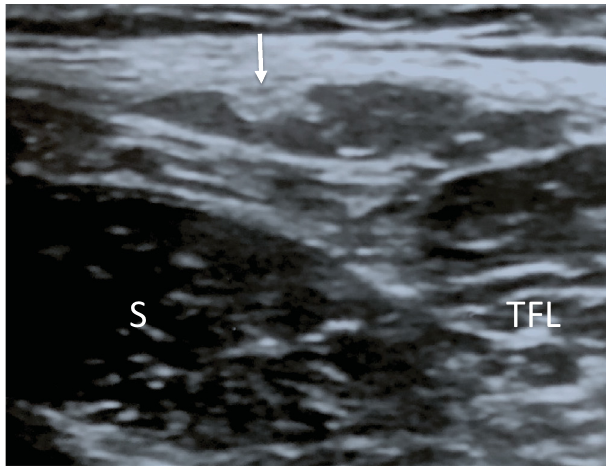
Figure 3. Transverse ultrasound image of the Non-Fan type within the intermuscular space between the sartoirus and the tensor fascia latae. S: Sartorius, TFL: tensor fascia latae muscle, Arrow: nerve branch.